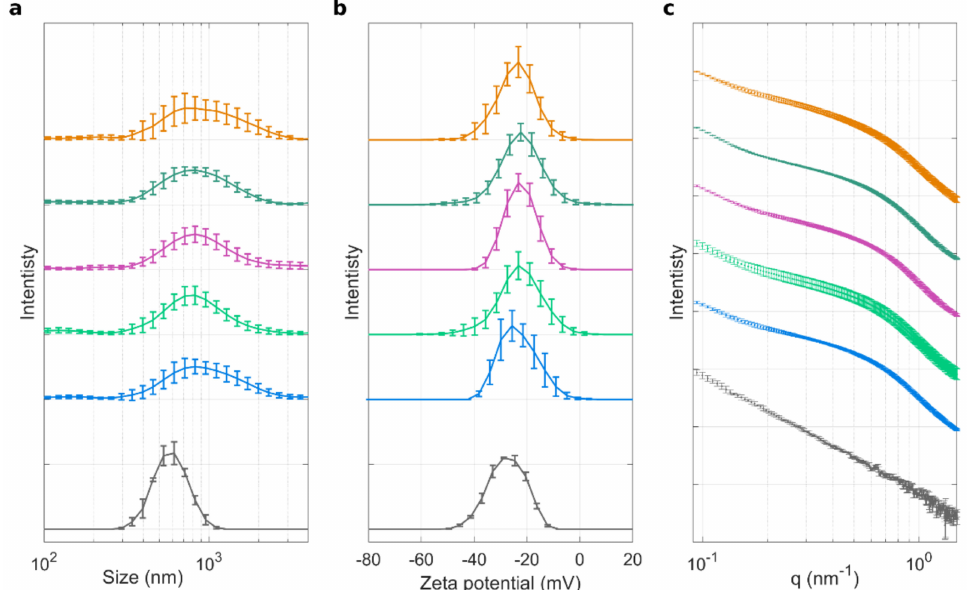
Figure 2. Characterization of GO sheets and GO–HP complexes. ( a ) Size distributions, ( b ) zeta potential distributions, and ( c ) synchrotron SAXS curves for bare GO (grey) and GO–HP samples obtained from NOP (blue), breast cancer (light green), prostate cancer (purple), colon cancer (dark green), and pancreatic ductal adenocarcinoma (PDAC) patients (orange). For each condition, each distribution is the average of five independent distributions, one for each of the single five